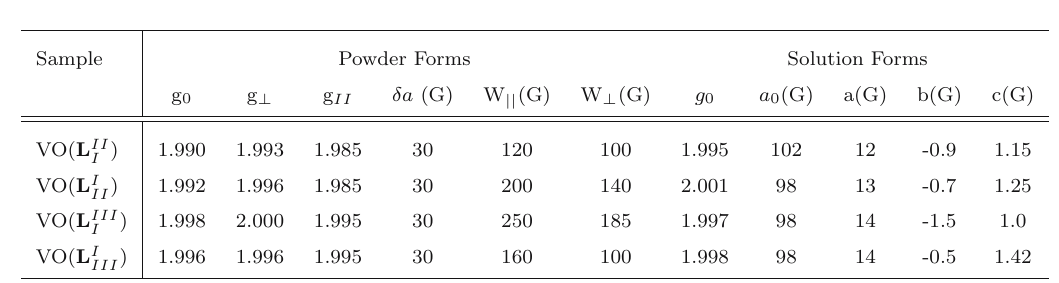
Table 4 EPR and line width parameters obtained from theoretical